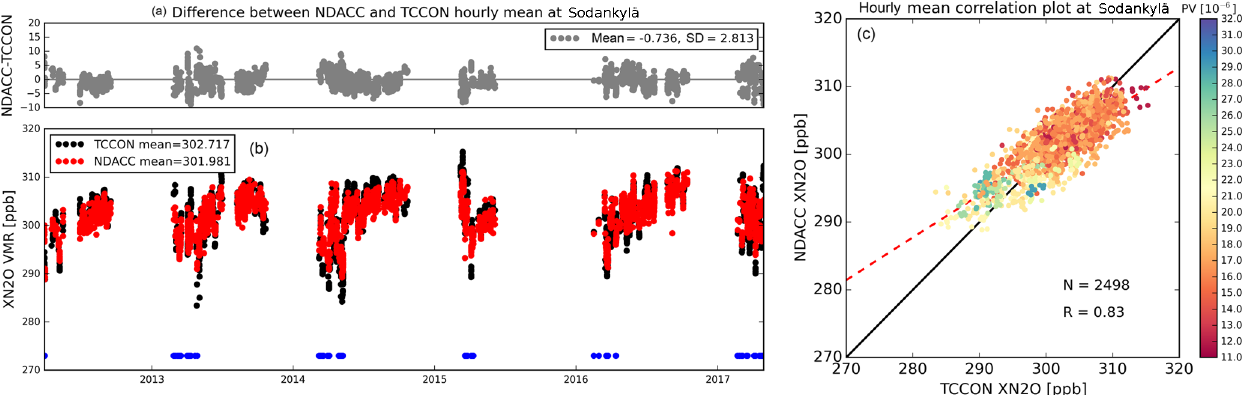
and updated retrieved X N using the ACE-FTS measurement as the a priori 2 O 2 O